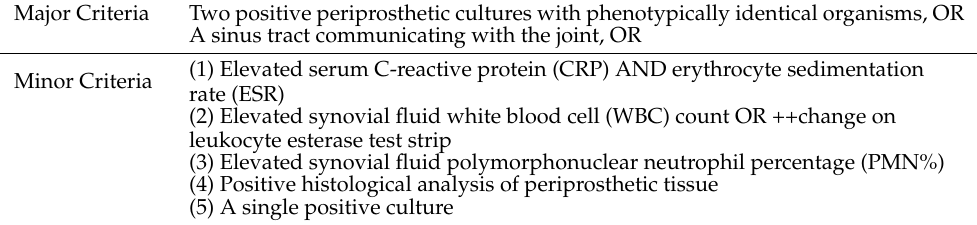
Table 1. Definition of Periprosthetic Join Infection * [31]. Reproduced with permission from Javad Parvizi and Thorsten Gehrke, The Journal of Arthroplasty; published by Elsevier, 2014. Major Criteria Two positive periprosthetic cultures with phenotypically identical organisms, OR A sinus tract communicating with the joint, OR